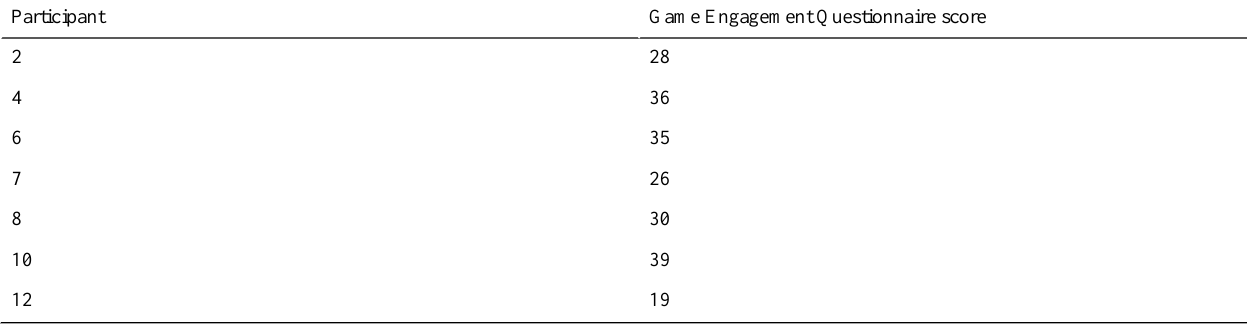
Table 5. Total scores for the Game Engagement Questionnaire.